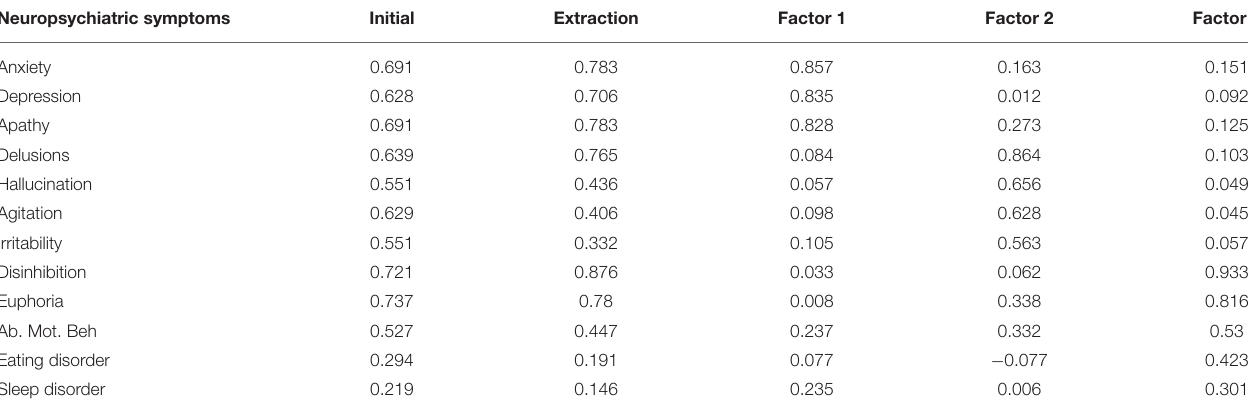
TABLE 2 | Communalities and rotated factor matrix of the NPS group.